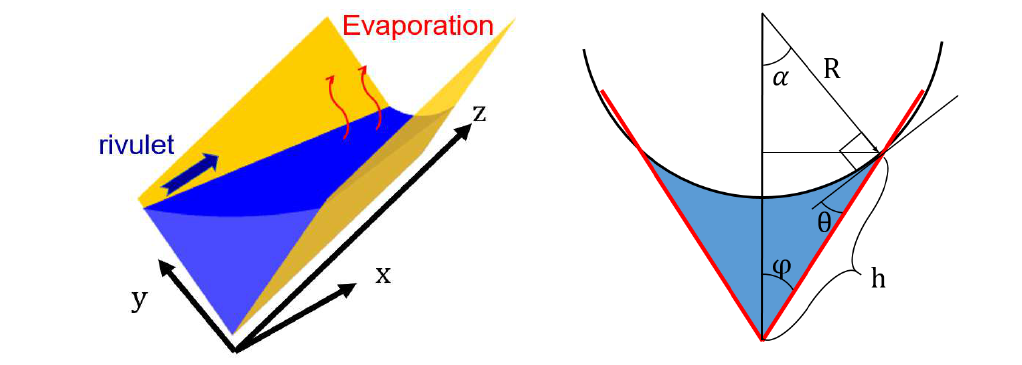
Fig. 1 . The scheme of the channel. Fig. 2 . Cross-section of the channel. Wetted length on the side of the channel is h